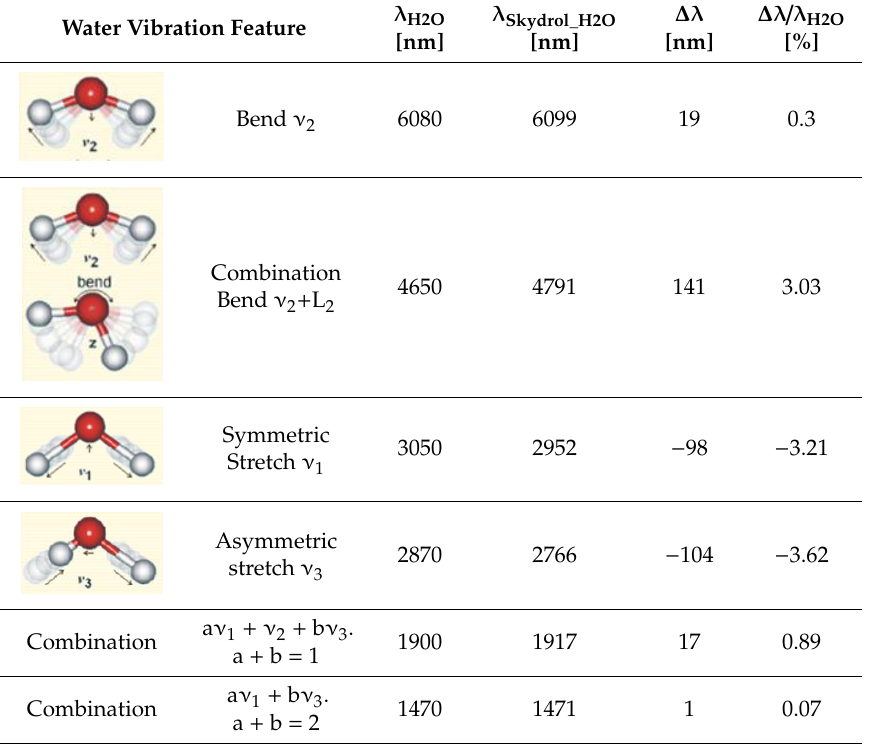
Table A1. Wavelengths of vibrational features in liquid water (column 3) and of water molecules dissolved in Skydrol LD4 (column 4). Columns 5 and 6 report the corresponding wavelength shifts.